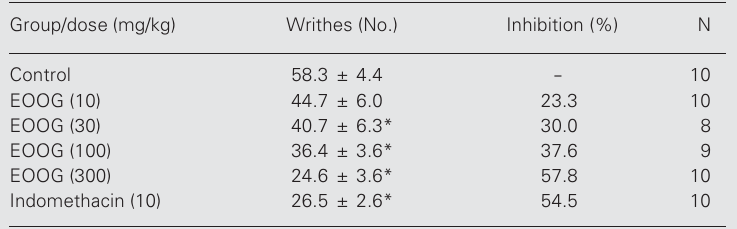
Data are reported as means ± SEM. N indicates the number of animals per group. *P<0.05 vs control (Student t -test).